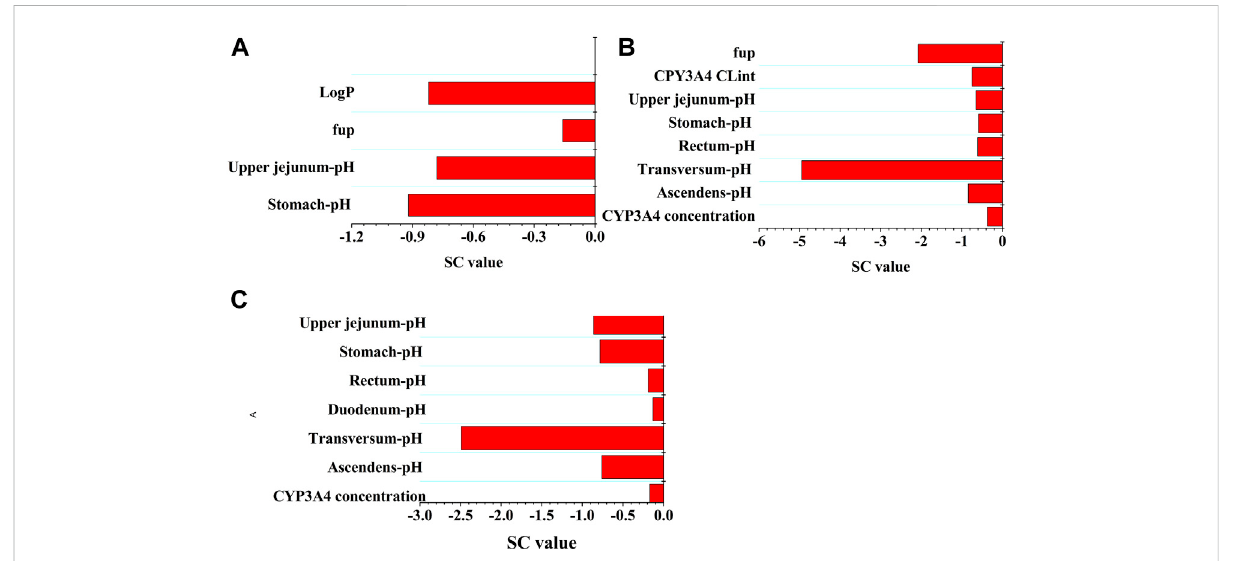
FIGURE 4 Sensitivity analysis of the PBPK model. The parameter sensitivity of the PBPK model to single parameter is measured with the change of the predicted C max (A) , the predicted C trough (B) , and AUC (C)